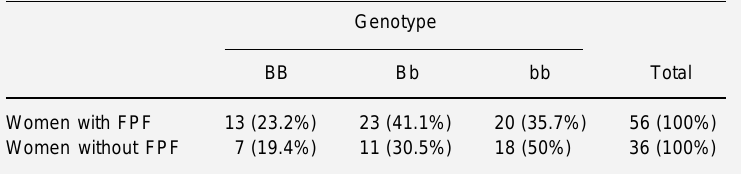
Table 2 - VDR genotype distribution in women with and without fractures of the proximal femur (FPF). With FPF ¬ without FPF . c 2 = 1.8. P =